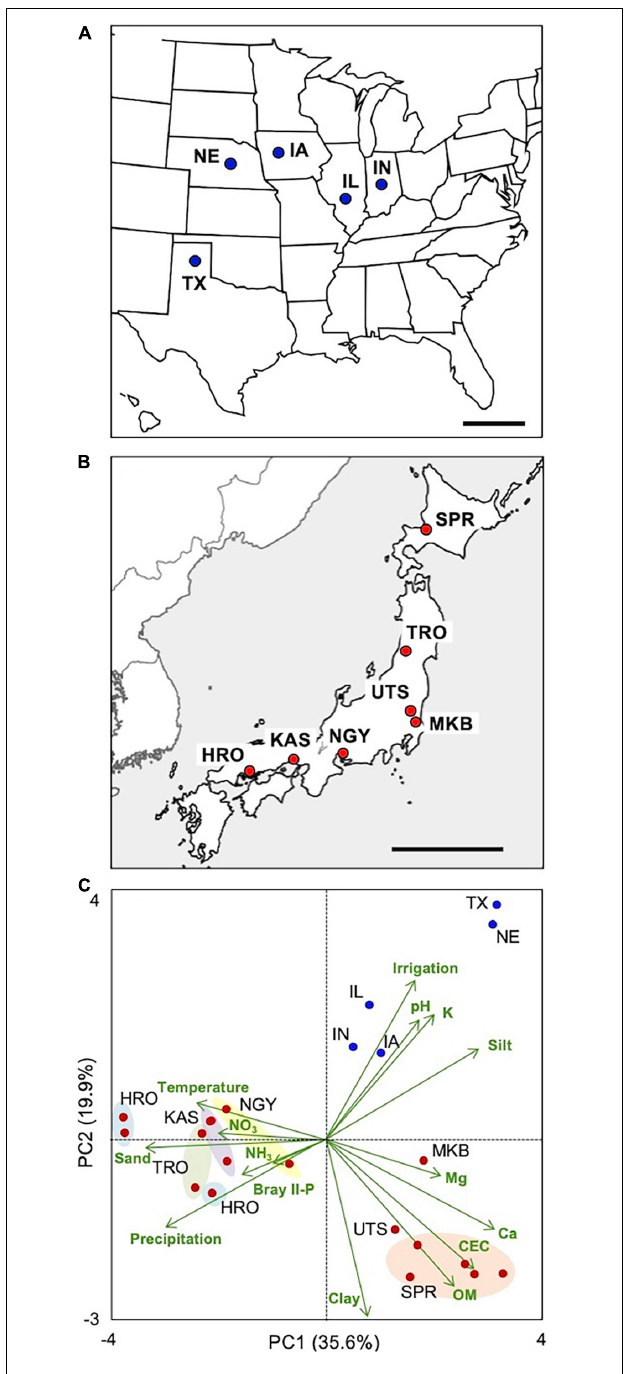
FIGURE 1 | Location and characterization of the maize sampling sites. Roots, shoots, and root-zone soils were collected across the (A) United States Corn Belt and (B) Japan. (C) Principal component analysis of soil, climatic, and agricultural (irrigation) variables of the five sites in the United States and those of 17 experimental plots in the seven sites in Japan. Different experimental plots of the seven sites are circled with colors. Detailed information/data on the plots/sites is provided in Supplementary Tables 1, 4 . IL, Illinois; IN, Indiana; IW, Iowa; NE, Nebraska; TX, Texas; SPR, Sapporo; TRO, Tsuruoka; UTS, Utsunomiya; MKB, Makabe; NGY, Nagoya; KAS, Kasai; HRO, Hiroshima. Scale bars: 500